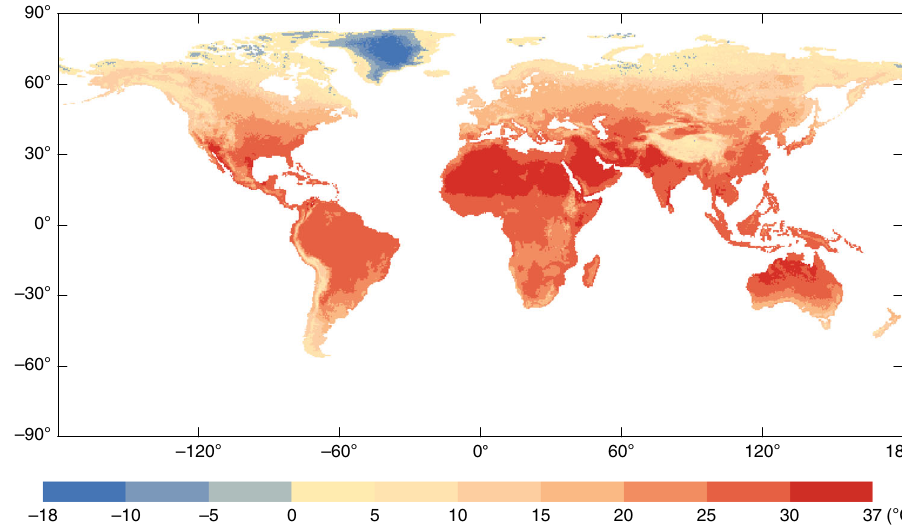
Fig. 4 The global distribution of minimum mortality temperatures estimated for each 0.5°× 0.5° grid during the 2010s